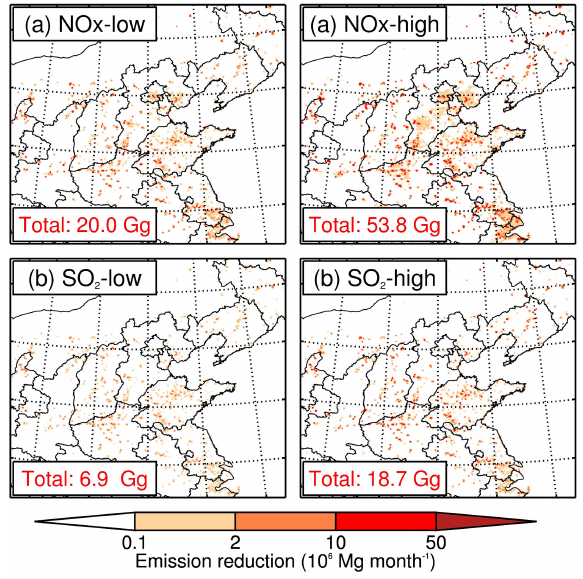
Figure 6. The spatial comparisons of predicted and observed episode-averaged mass concentrations of PM 2 . 5 , NO 2 , and SO 2 . (a) Statistical comparison of predicted and observed mass concen- trations, with the correlation coefficient ( r ). Horizontal distributions of predictions (color contour) and observations (colored circles) of (b) PM 2 . 5 , (c) NO 2 , and (d) SO 2 , along with the simulated wind fields (black arrows).